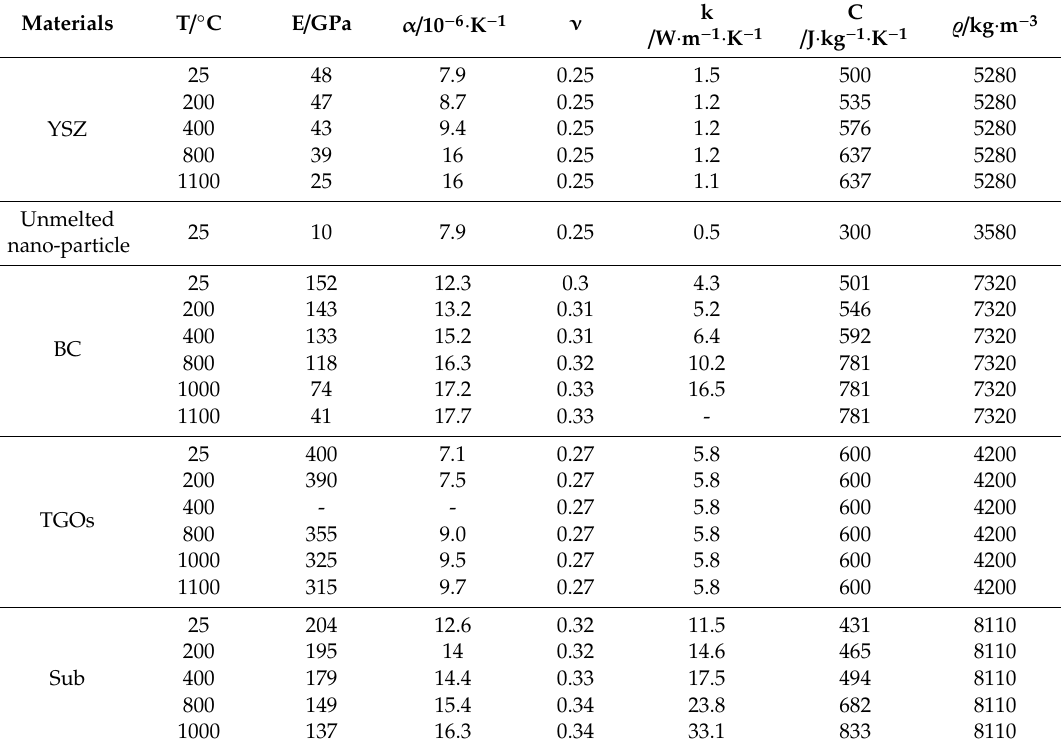
Table 1. Material thermophysical parameters of TBCs system.